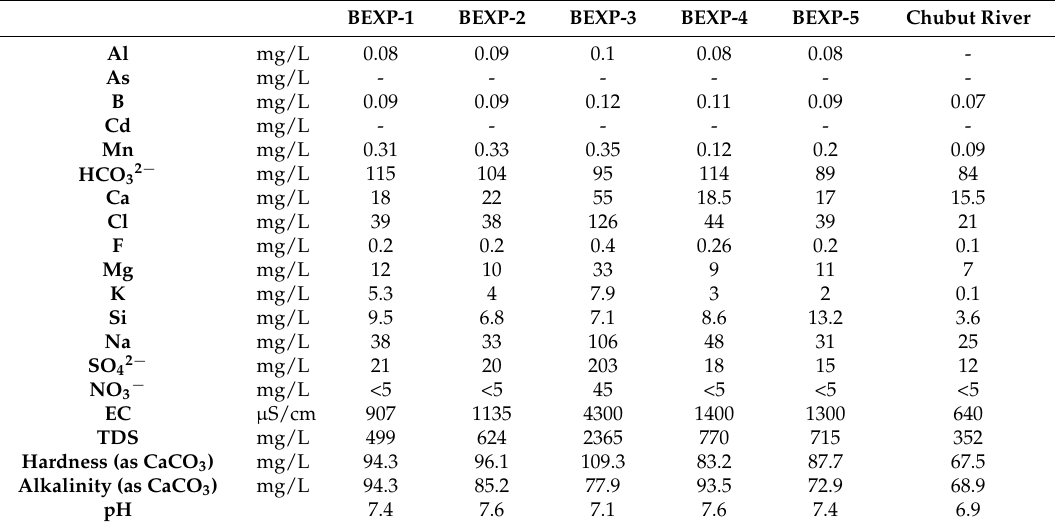
Table 3. Major ion concentrations in the